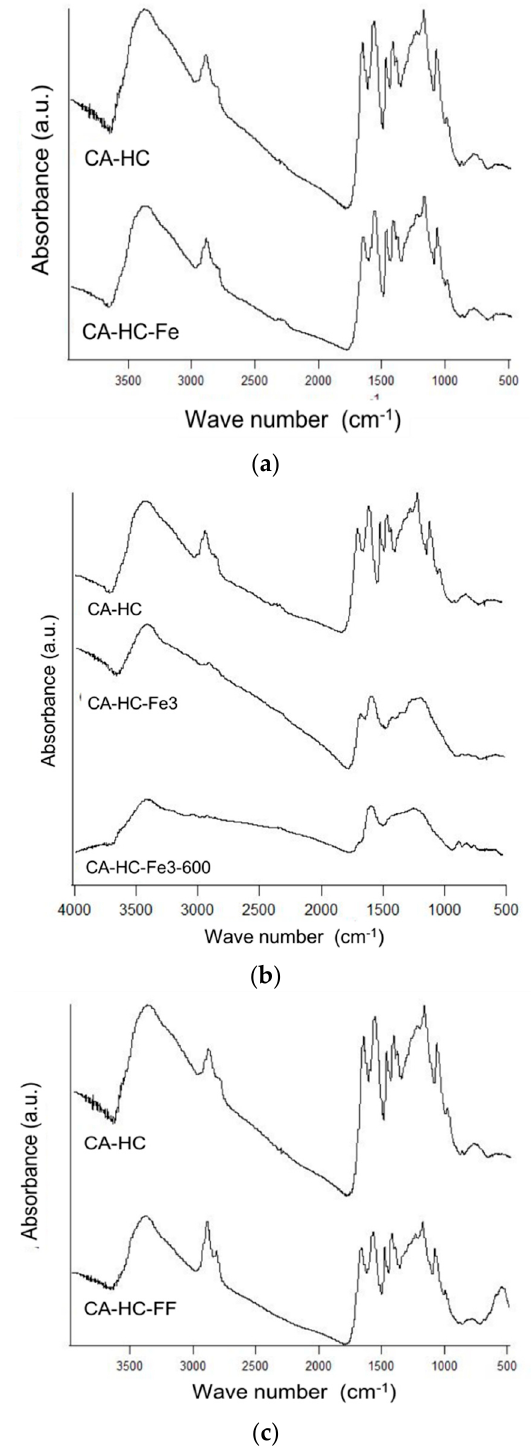
Figure 5. FT-IR spectra of CA–HC–Fe ( a ), CA–HC–Fe 3 and CA–HC–Fe 3 -600 ( b ), and CA–HC–FF ( c ). The spectra of the sample CA–HC has been included in all cases to facilitate comparison.